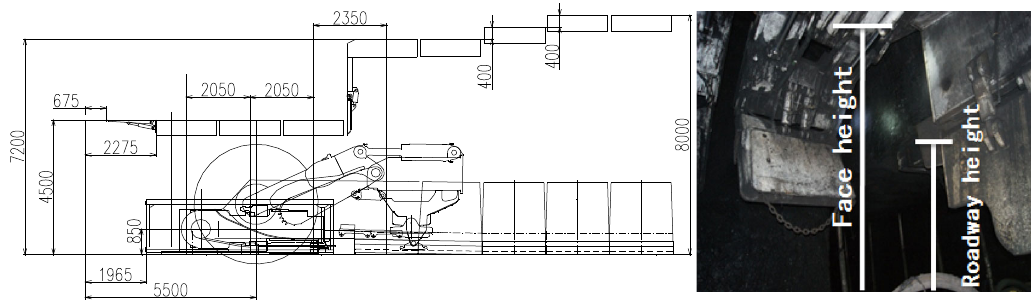
Fig. 5 Equipment matching manner for super cutting height